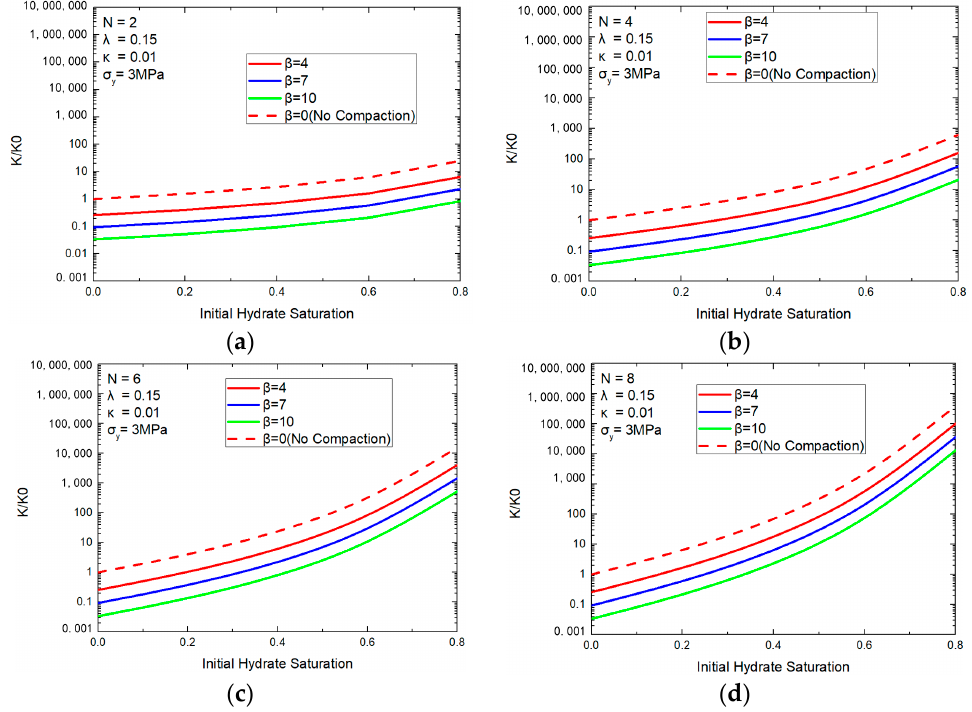
Figure 8. The effect of parameter β on the relationship between permeability ratio K/K 0 and initial hydrate saturation when ( a ) N = 2, ( b ) N = 4 , ( c ) N = 6 and ( d ) N = 8 in the case of constant temper- ature.